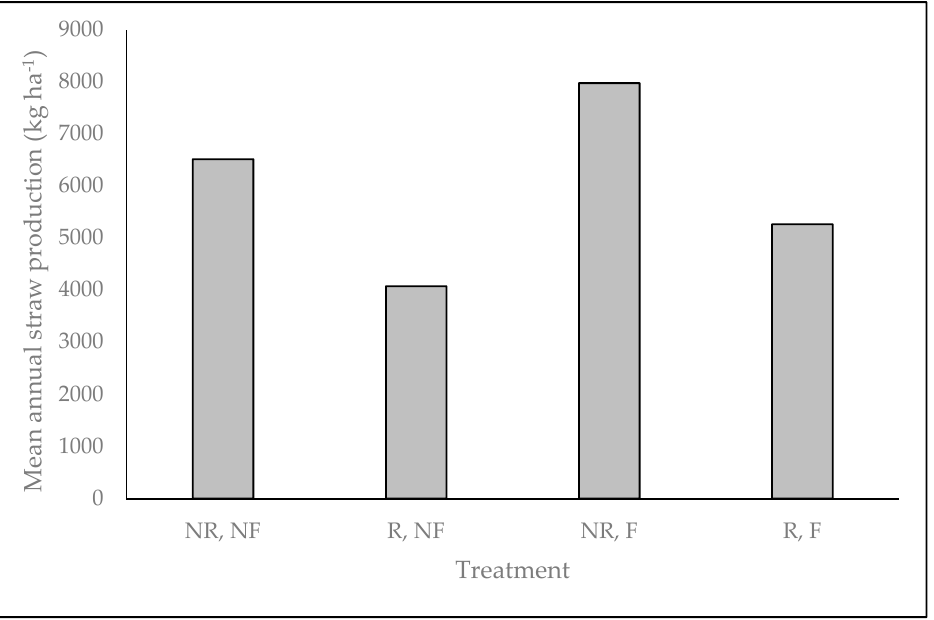
Figure 7. Loblolly pine mean annual pine straw production on a three-year raking regime over the seven year study period by treatment on a Fuquay soil [24]. Treatments: no rake, no fertilization (NR, NF); rake, no fertilization (R, NF); no rake, fertilization (NR, F); rake, fertilize (R, F) (refer to Tables 6 and 7 for study details, information on fertilizer treatments, and statistical test results).